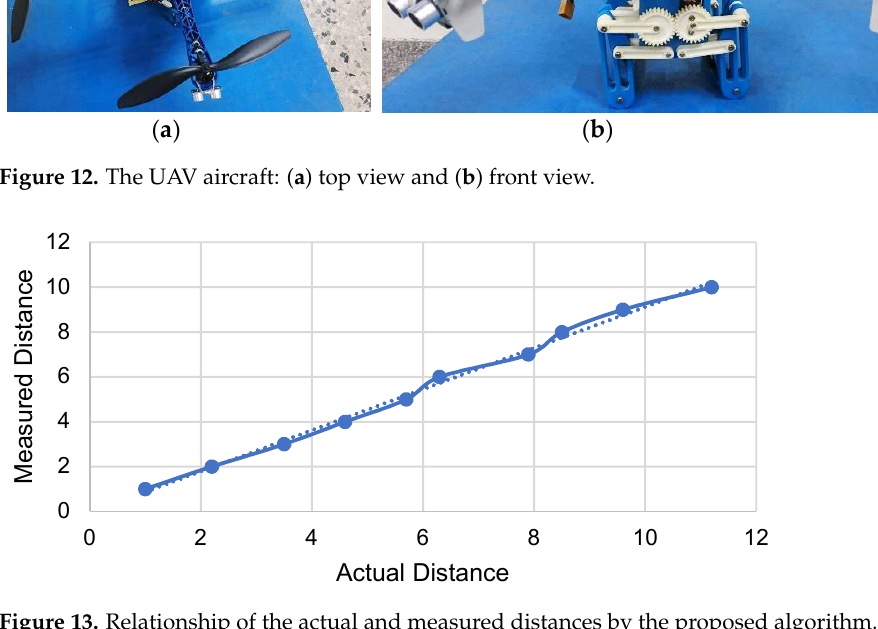
Figure 13. Relationship of the actual and measured distances by the proposed algorithm.